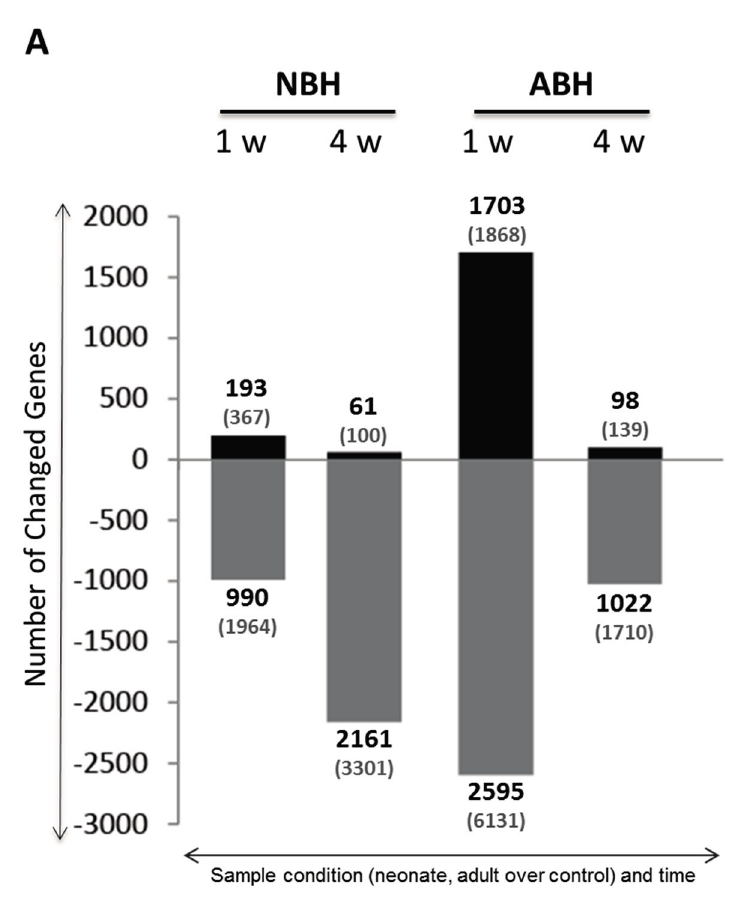
Figure 6. Differentially expressed genes in NBH and ABH, and validatory